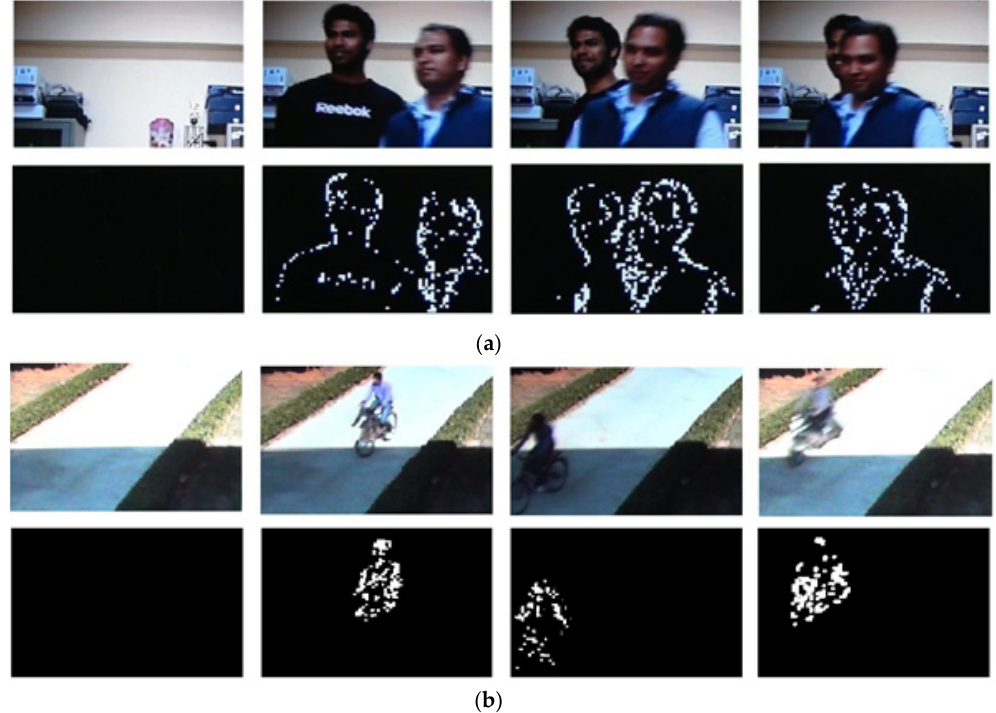
Figure 12. Moving Objects in Video Scene and Corresponding Motion Detected Outputs for Static Background Scenarios.